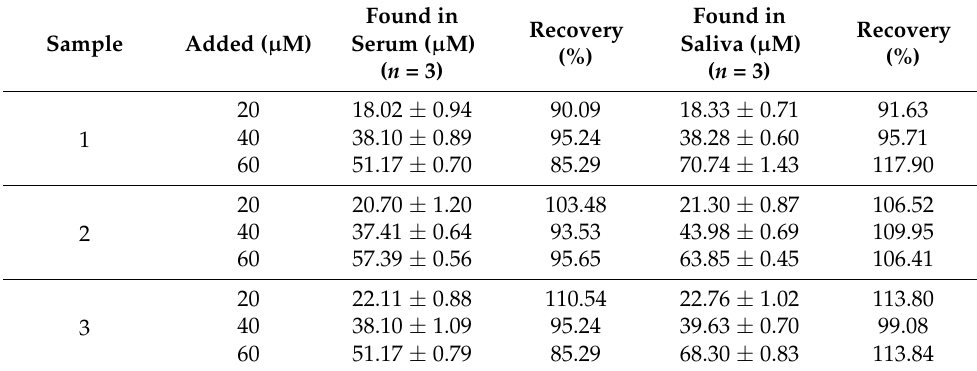
Table 4. Application of the proposed sensor Au@TiO 2 /MWCNTs/GCE for real sample analysis (human serum and saliva